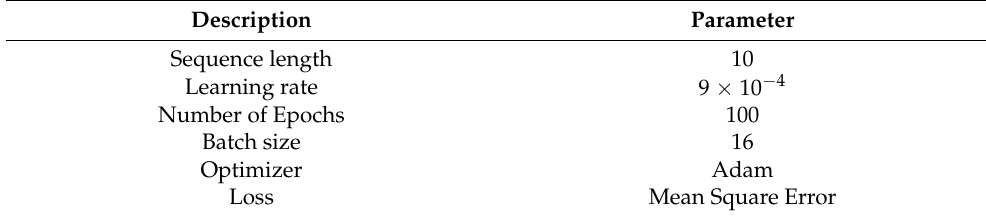
Table 3. Hyperparameters for RUL prediction